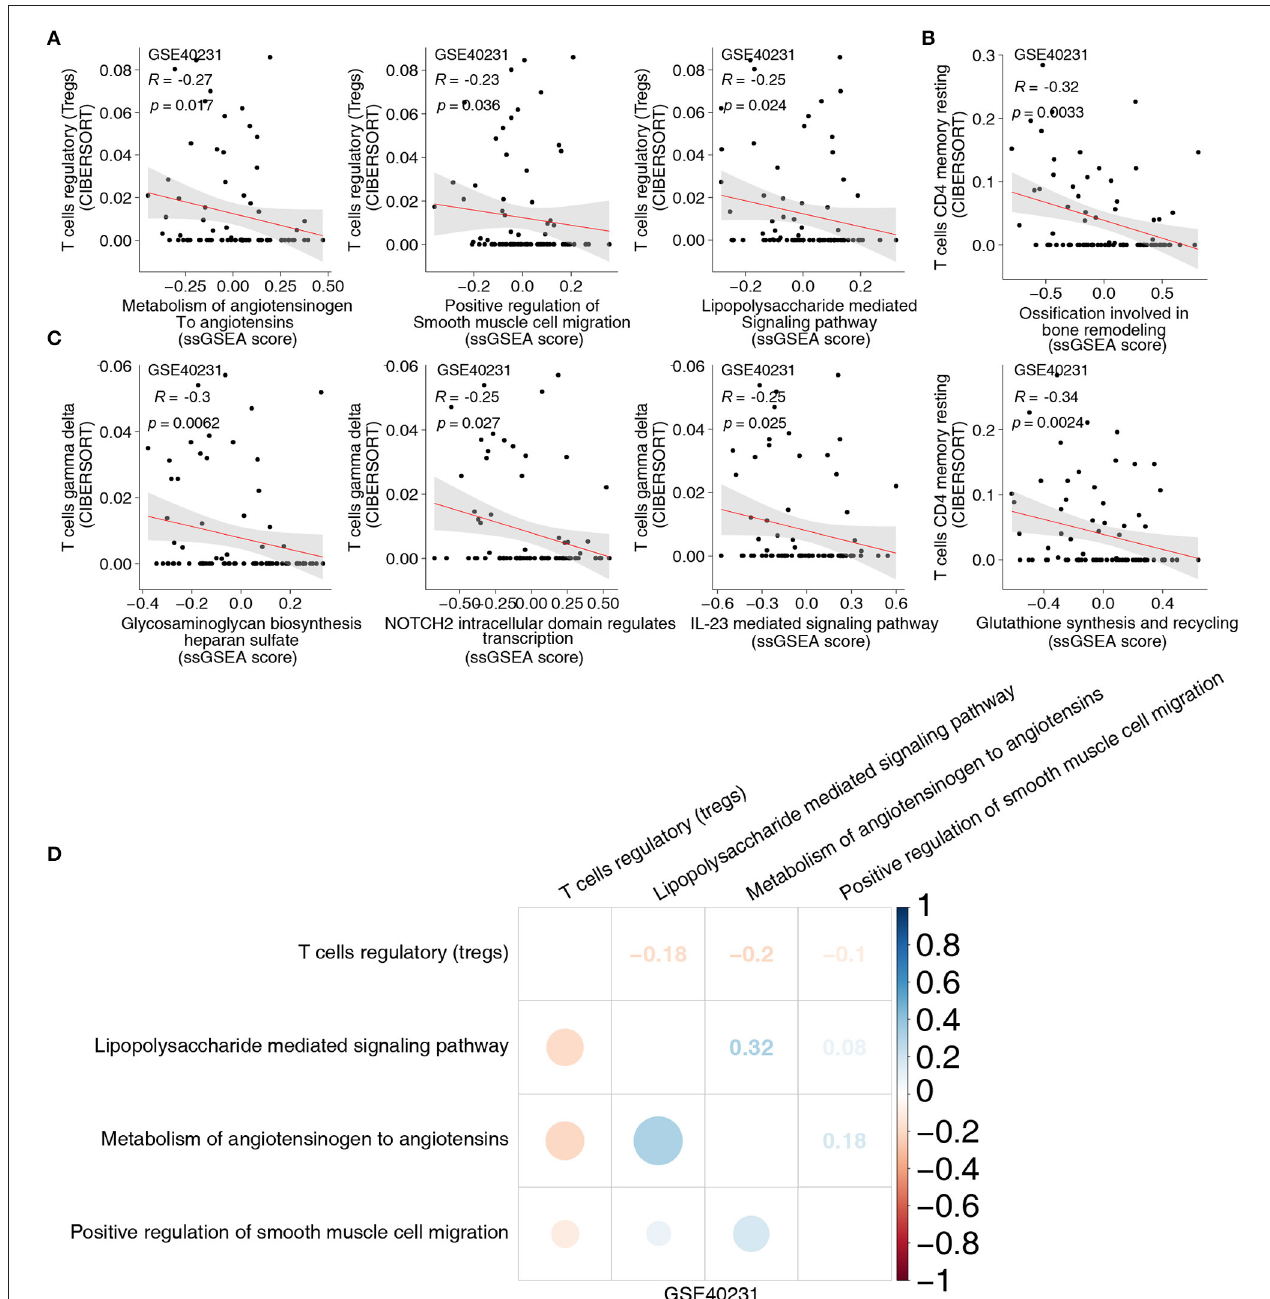
FIGURE 4 | (A) The correlation between the proportions of Tregs and the score of ssGSEA. (B) The correlation between the proportions of resting CD4 + T cells and the score of ssGSEA. (C) The correlation between the proportions of γδ T cells and the score of ssGSEA. (D) The correlation heatmap of the proportions of Tregs and the score of ssGSEA in each three-gene expression dataset (GSE40231). Tregs, regulatory T cells; ssGSEA, enrichment analysis; γδ T cells, gamma delta T cells.